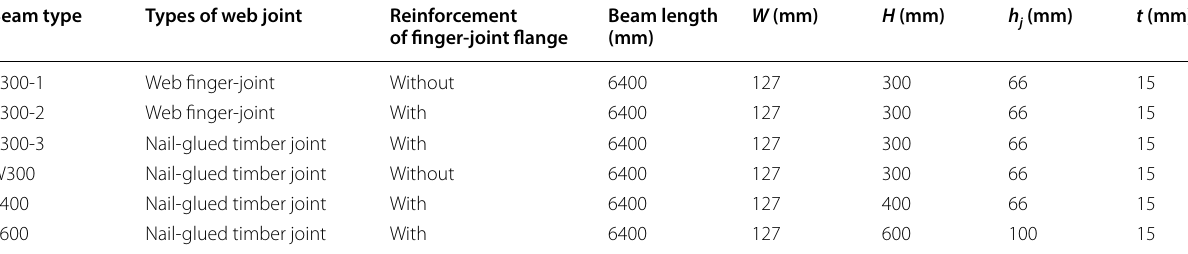
Table 2 Experimental design and dimensions of the